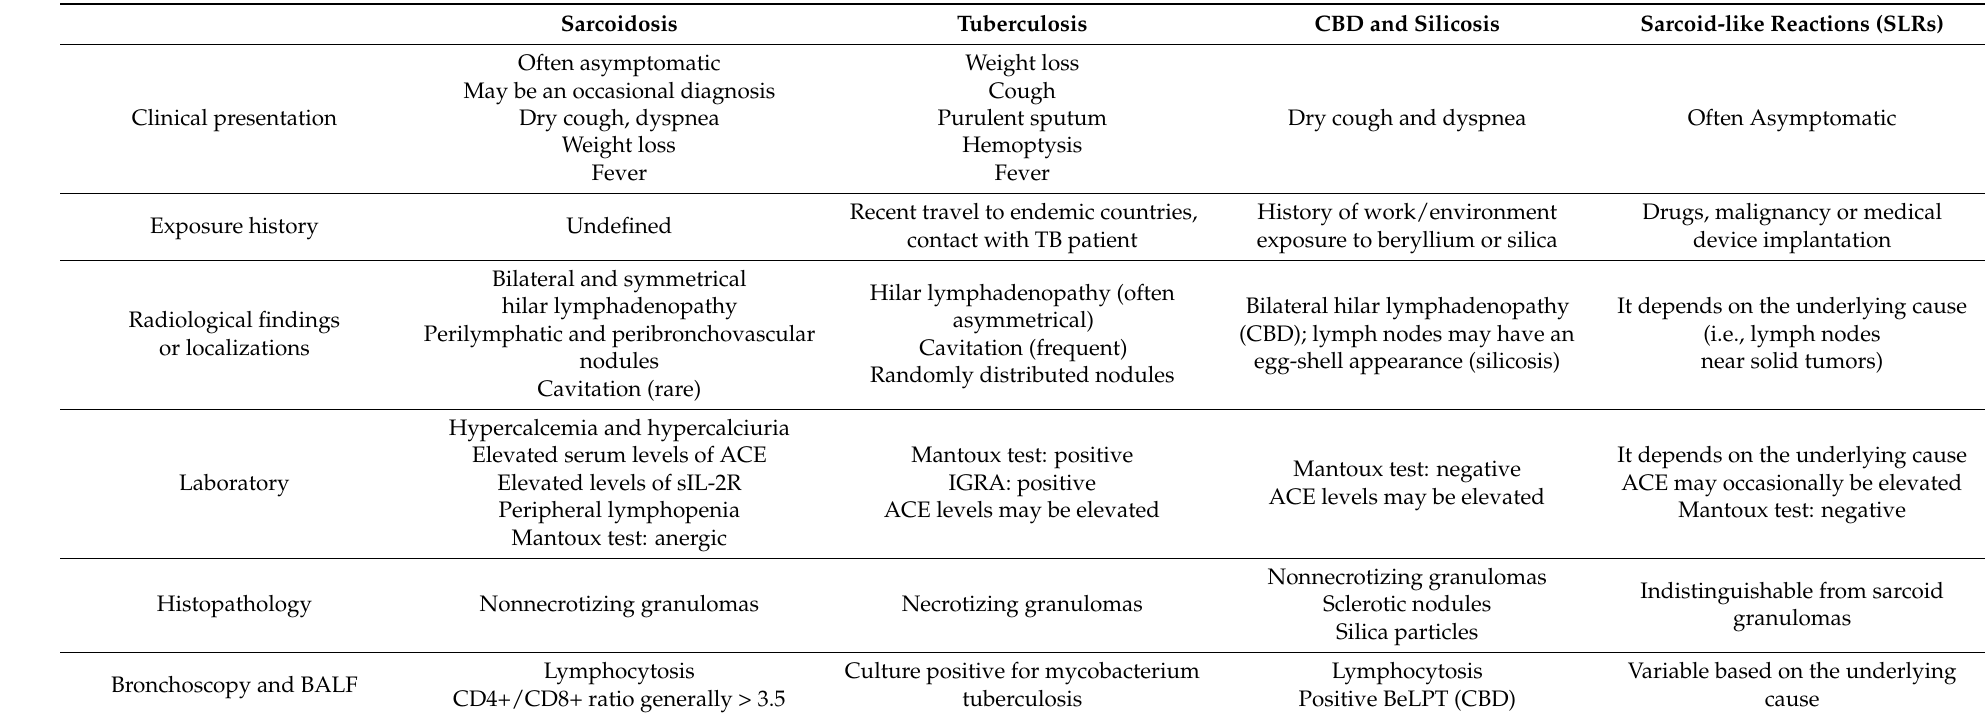
Table 2. Main differential diagnoses of